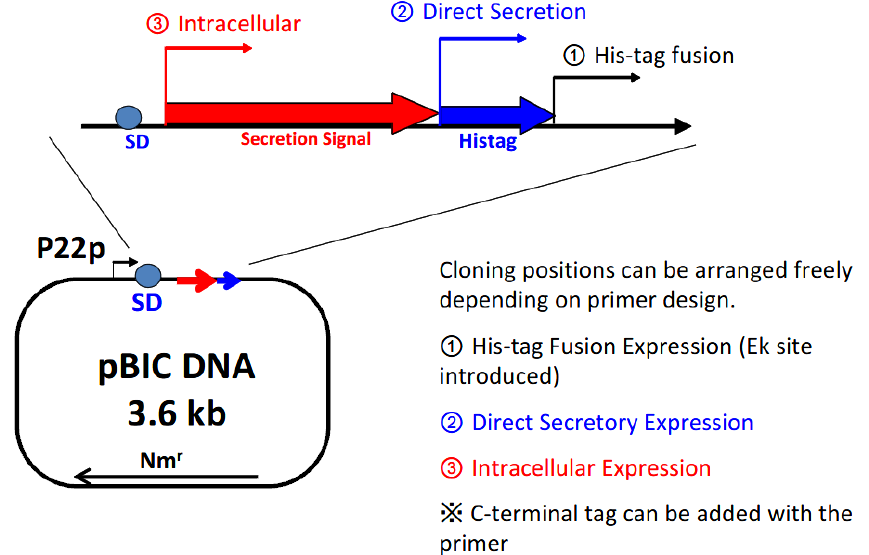
Figure 3. Selection of the expression mode with the BIC system. P22p, P22 promoter; SD, Shine–Dalgarno sequence; Nm r , neomycin-resistant